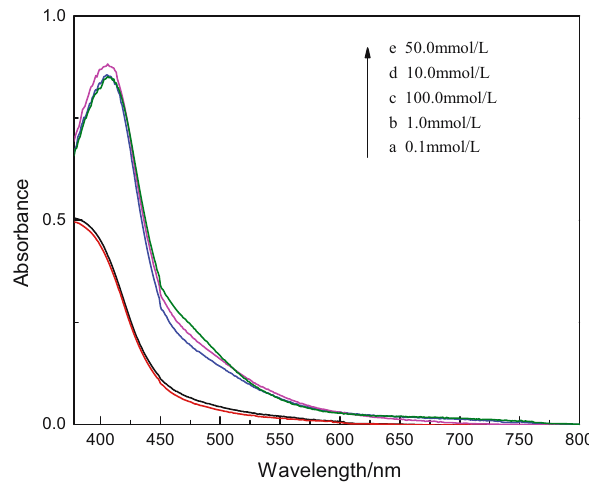
Figure 3: SPR absorption spectra of UV - Vis nano - selenium at di ff erent selenite